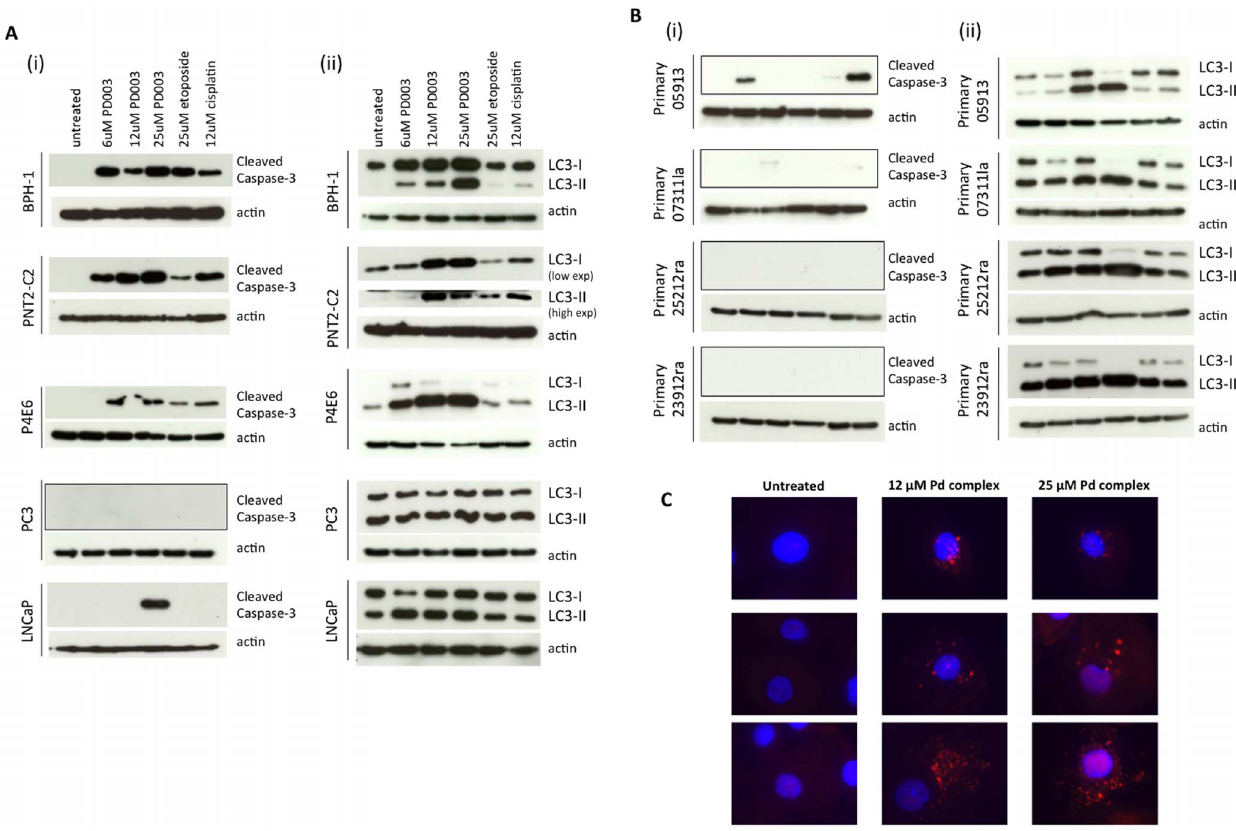
Figure 6. Expression of apoptosis and autophagy-related proteins following treatment with Pd complex. Normal (PNT2-C2) and benign (BPH-1) cell lines, three cancer cell lines (P4E6, PC-3 and LNCaP) (A) and four primary cultures (B) one derived from patient with BPH and three derived from patients with prostate carcinoma were treated with three concentrations of palladium complex or etoposide or cisplatin as control treatments. Lysates were harvested and Western blotting was carried out staining for cleaved caspase-3 indicative of apoptosis induction or LC3B protein, indicative of autophagy. (C) Images of primary cells (sample 23912) treated with Pd complex and stained with LC3-B antibody. Shown are three example images of untreated cells and cells treated with 12 m M and 25 m M Pd complex. Autophagosome vesicles are clearly visible in red.